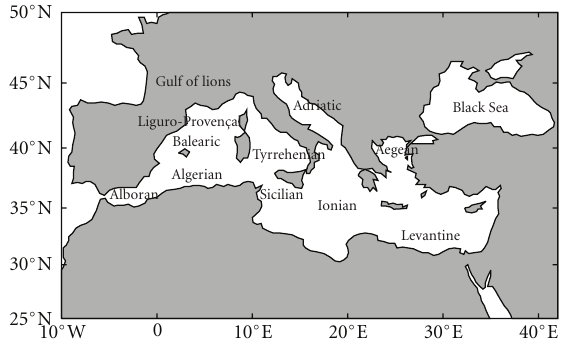
Figure 1: Map of the Mediterranean Sea. The main basins and subbasins are